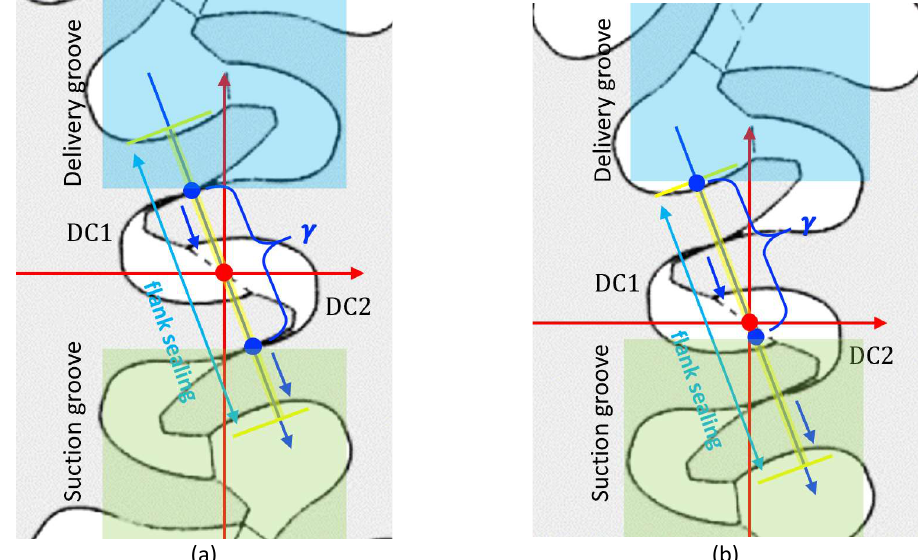
Figure 15: Examples of groove geometry design for single-flank involute EGPs (a) maximum-delivery (b) Figure 15. Examples of groove geometry design for single-flank involute EGPs ( a ) maximum-delivery minimum-delivery. ( b )